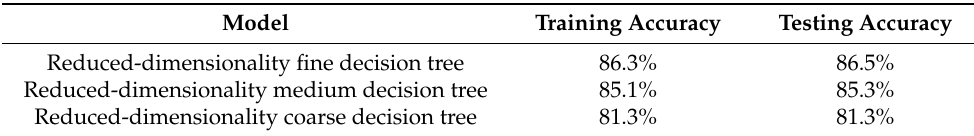
Table 5. Classification accuracy of reduced-dimensionality classifiers.